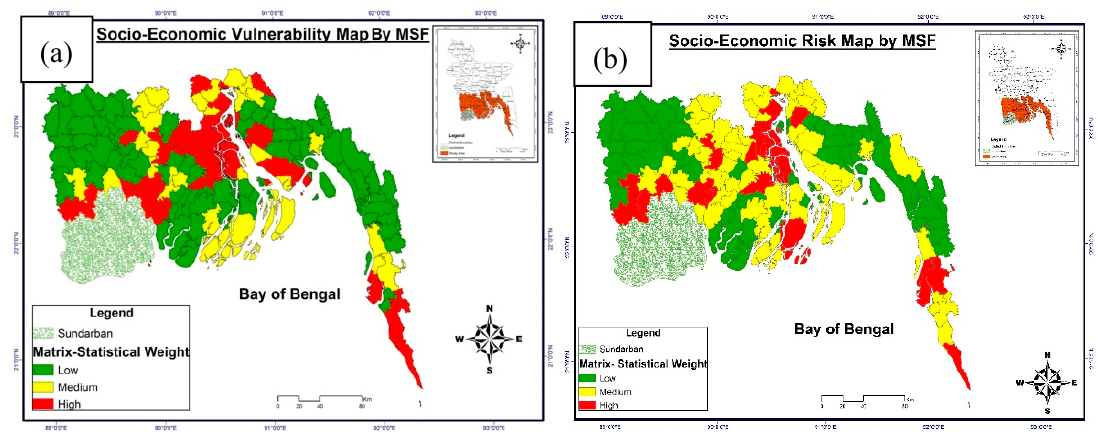
Figure 2. Vulnerability ( a ) and risk ( b ) maps using matrix based statistical framework (MSF).